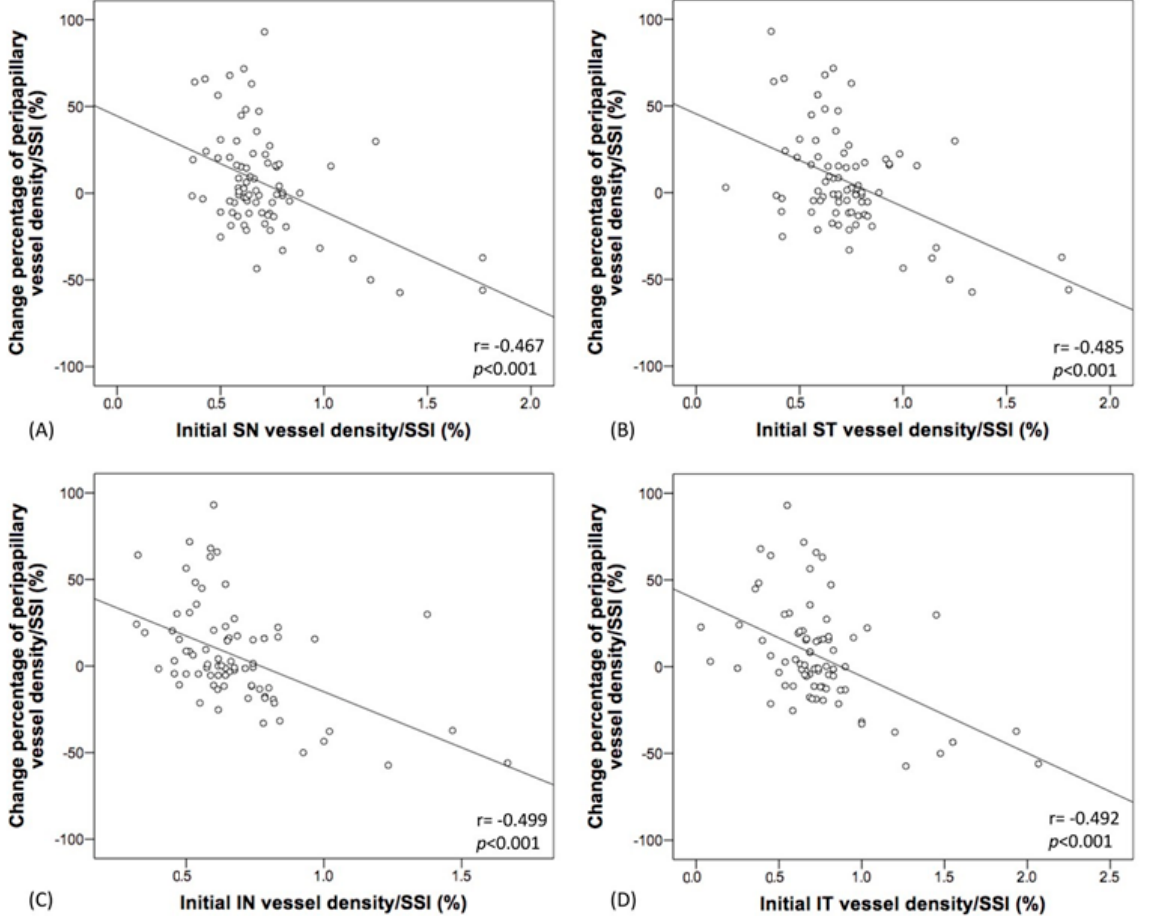
Figure 6. Scatterplots between initial superior nasal (SN) peripapillary vessel density (VD)/signal strength index (SSI) and percentage change in peripapillary VD/SSI ( A ); between initial superior temporal (ST) peripapillary VD/SSI and percentage change in peripapillary VD/SSI ( B ); between initial inferior nasal (IN) peripapillary VD/SSI and percentage change in peripapillary VD/SSI ( C ); and between initial inferior temporal (IT) peripapillary VD/SSI and percentage change in peripapillary VD/SSI ( D ) after the 6-month topical carteolol treatment in patients with normal-tension glaucoma. (Sample size n = 80, r: Pearson correlation coefficient, p : p value of Pearson correlation)